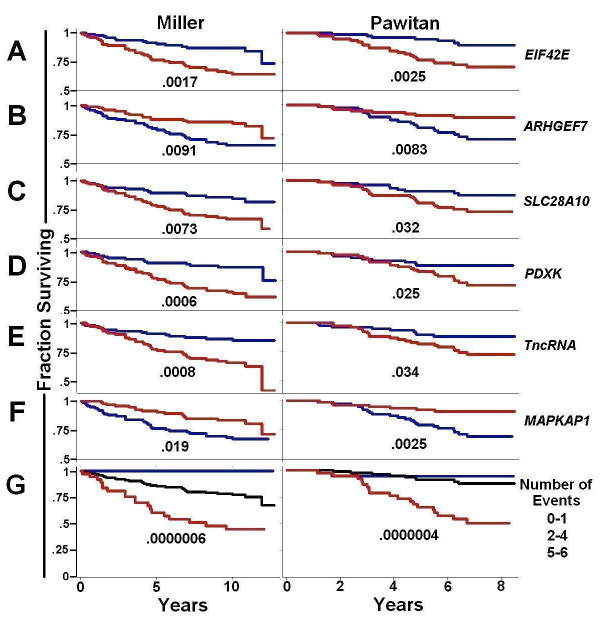
A six isoform signature provides improved prediction of breast cancer survival compared to individual isoforms. The fraction of patients surviving in each cohort (vertical axis) is shown over time in years (horizontal axis) as a function of individual probeset expression or SplicerAV index. Survival of patients in the top (red line) and bottom (blue line) 50th percentile are plotted by the SplicerAV index for six genes; EIF4E2 (A), ARHGEF7 (B), SLC28A10 (C), PDXK (D), TncRNA (E), MAPKAP1 (F) for the Miller (left) and Pawitan (right) cohorts. Patients survival stratified by a low (0-1), intermediate (2-4), and high (5-6) number of poor prognostic events is shown in panel G.